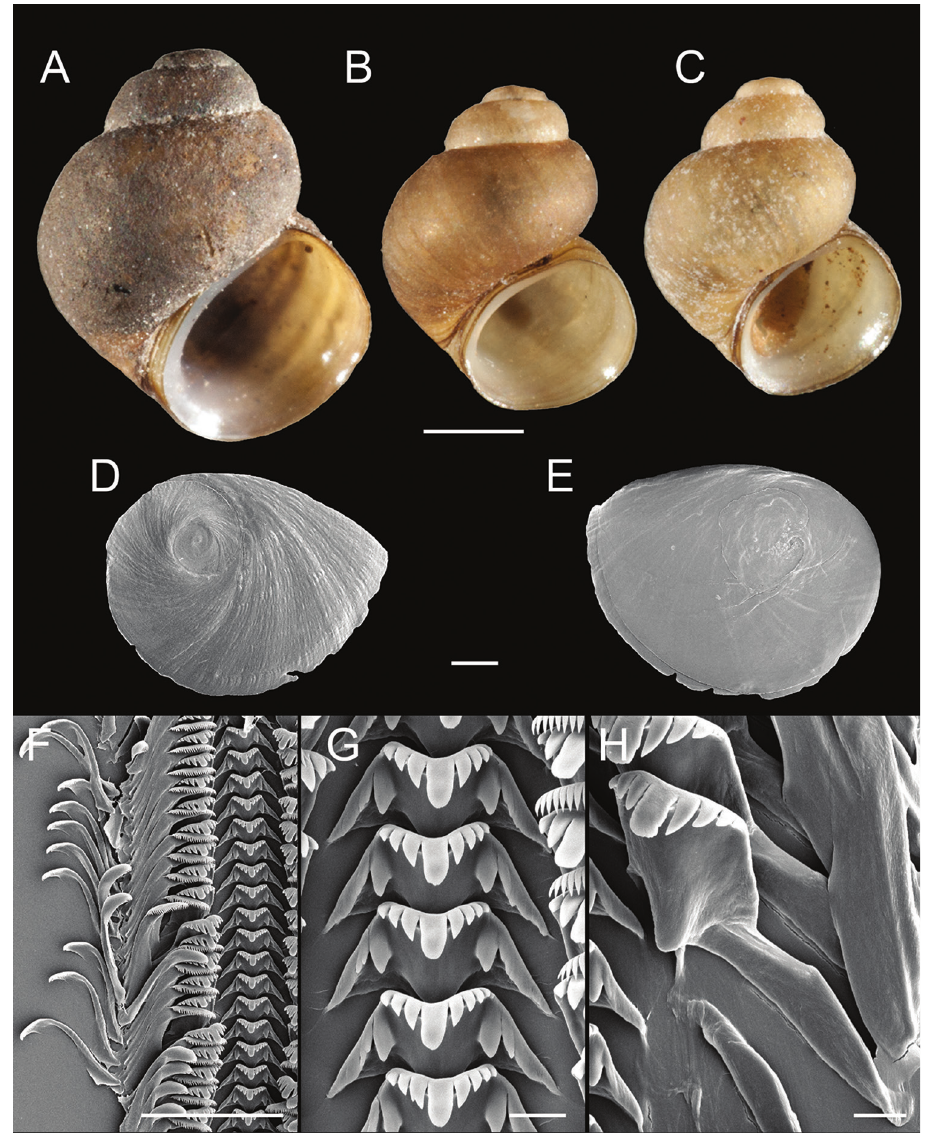
Figure 3. Shells, opercula and radula, F. multifarius . A Shell, USNM 1144567 B Shell, USNM 1144997 C Shell, USNM 1145051 D, E Opercula (outer, inner sides), USNM 1144567 F Portion of radular rib- bon, USNM 1144567 G Central teeth, USNM 1144567 H Lateral teeth, USNM 1144567. Scale bars: A–B 1.0 mm; D–E 250 µm; F , 100 µm; G–H 10 µm. (42.2890°N, 122.5262°W), USNM 1144582, USNM 1144583, USNM 1144584, USNM 1144682, USNM 1145010, USNM 1145011, USNM 1145012, USNM 1297162, spring on north side of Burnt Creek Road (BLM 39-3E-21.0), 0.64 rd.